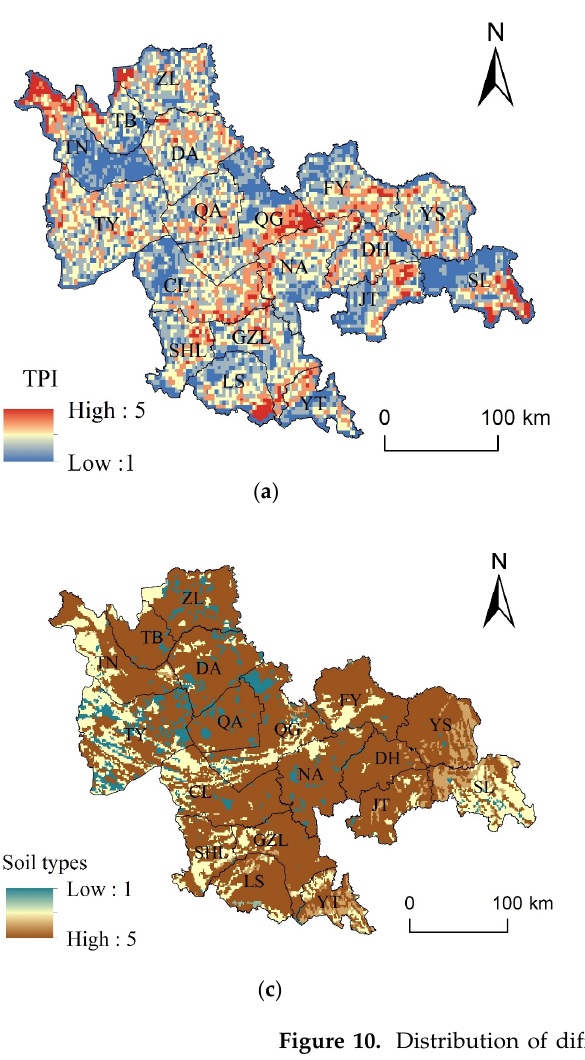
Figure 11. Distribution of agricultural disaster-pregnant environment integrated index.